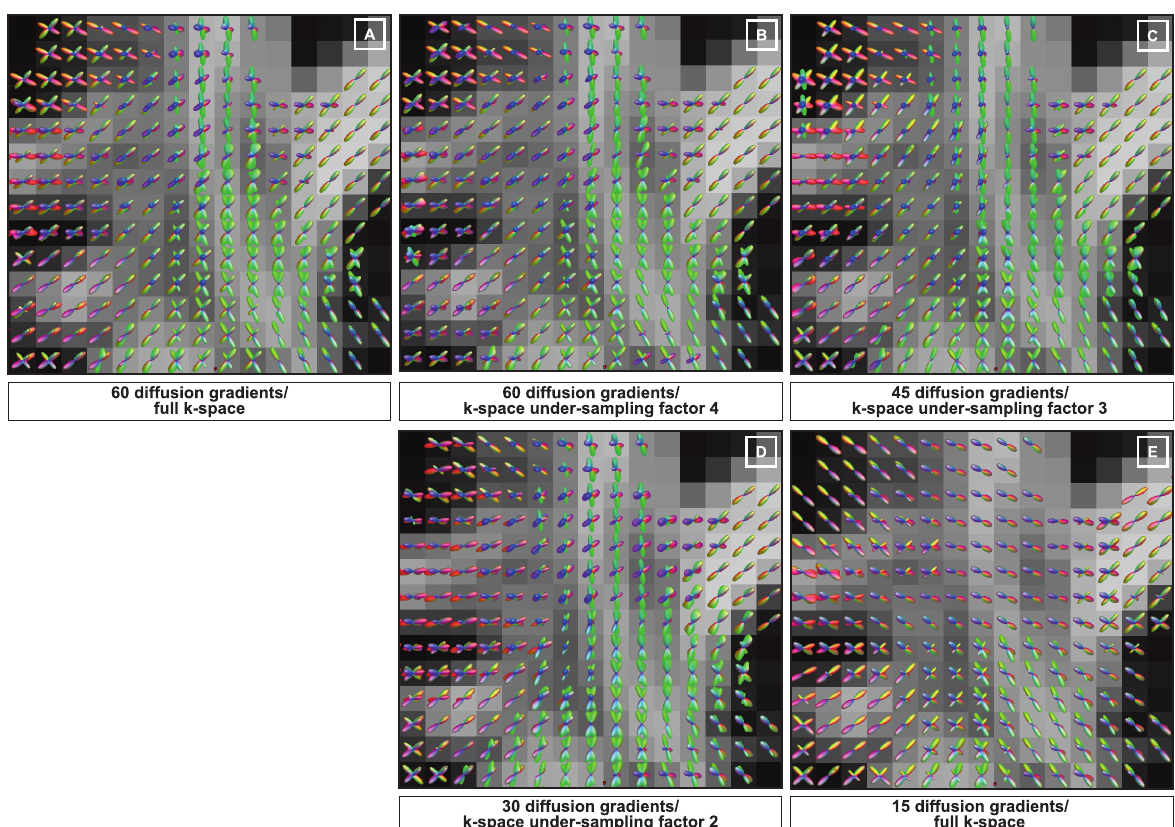
Figure 8. Qualitative evaluation of the fiber orientation reconstruction performed on the real data by using the proposed kq-space under-sampling framework. The fiber configurations displayed correspond to the region framed highlighted by the white frame in Figure 7. Reconstructions were performed considering 60 diffusion with full k-space ( A ), and with k-space under-sampling factor of 4 ( B ), considering 45 diffusion gradients with k-space under-sampling factor of 3 ( C ), 30 diffusion gradients with with k-space under-sampling factor of 2 ( D ) and 15 diffusion gradients with full k-space ( E ). Table 1. Comparison of the computational time required for the FOD recovery from the real data, considering four different under-sampling settings, using either 17 coils (deterministic approach) or 12 coils selected randomly per iteration (stochastic approach). Samp. 17 Coils (Deterministic) 12 Coils (Stochastic) q k Time per Iter. (s) Iter. Time per Iter. (s)